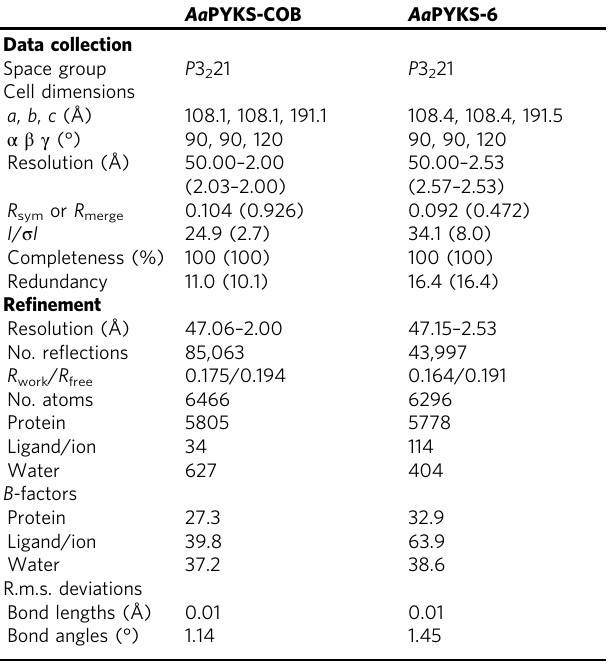
Table 1 Data collection and re fi nement